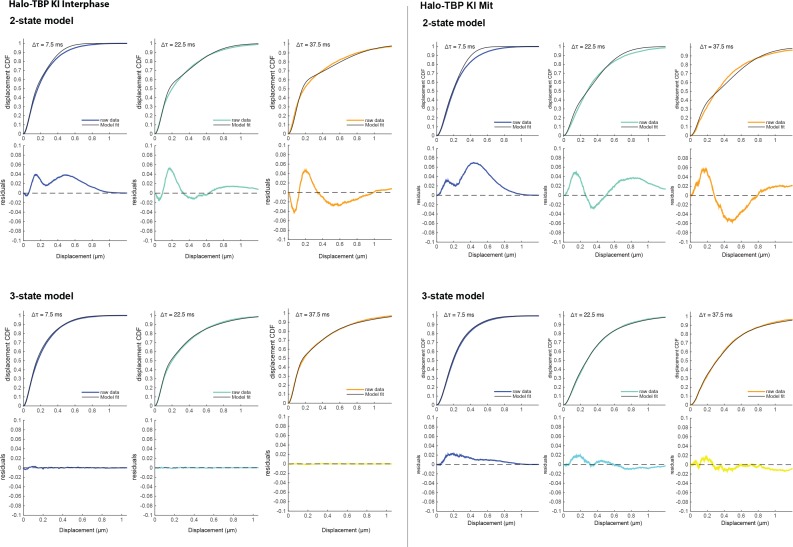
Model fitting of Halo-TBP fast tracking data for interphase and mitotic cells.The displacement CDFs for consecutive time frames, from Δτ = 7.5 ms to Δτ = 45.0 ms, are plotted for Halo-TBP in interphase (left) and mitotic cells (right) as colored lines. The displacement CDF is then fitted with a 2-state (top) or a 3-state (bottom) model. The resulting fit is plotted as a black line, and the corresponding residuals from the fit is plotted below for each consecutive frame. The 2-state model resulted in large residuals after fitting, necessitating a 3-state model.